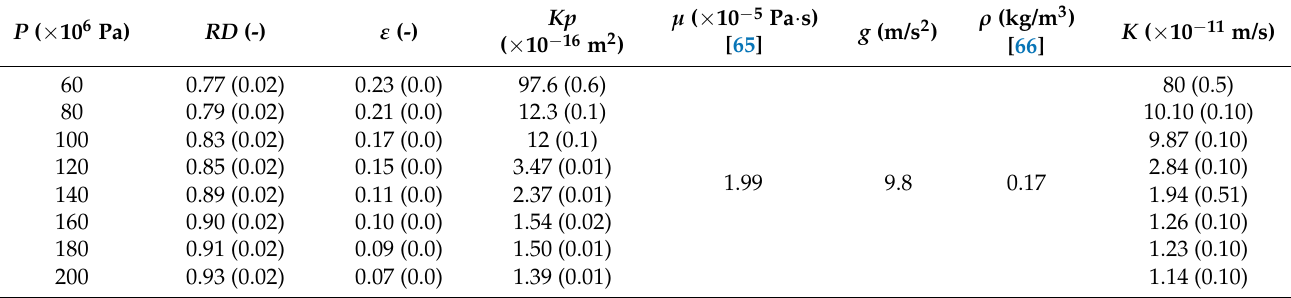
Table 4. Hydraulic conductivity calculated with helium properties.